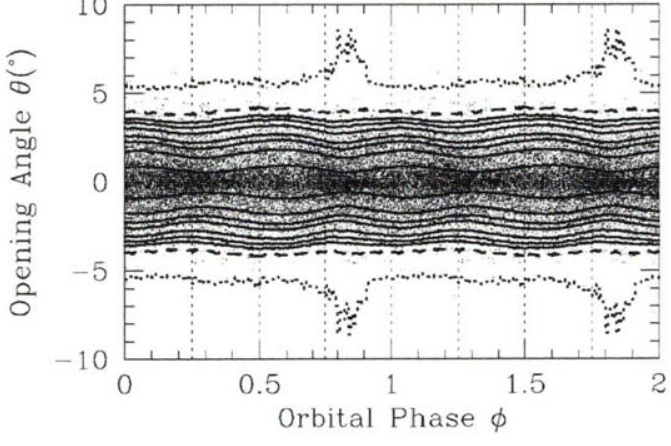
Fig. 3. The ((f), 6) projection of the disc. Only 30 000 particles are shown. The contour levels shown as solid lines are - moving out from the mid-plane - #50, 075, $85 > $90? $95t $97 and O qs - The $99 contour is shown as a dashed line, and the 6*99.9 contour as a dotted line. The thickening from the accretion stream is most evident in the 99.9% contour, but only marginally evident in the 99%